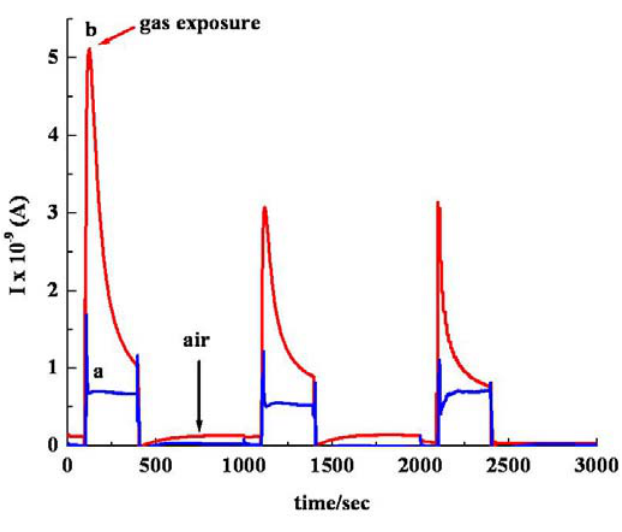
Figure 9. Reversibility of sa MWCNTs/Nylon-6 nanofibers when exposed to solvents: (a) acetone, (b) trichloromethane at room temperature.